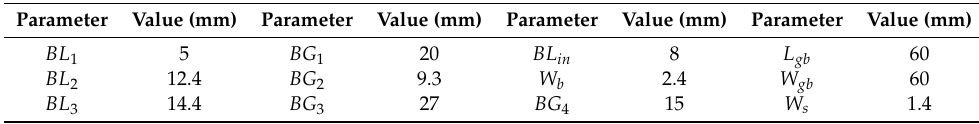
Table 4. Optimized dimensions of the proposed